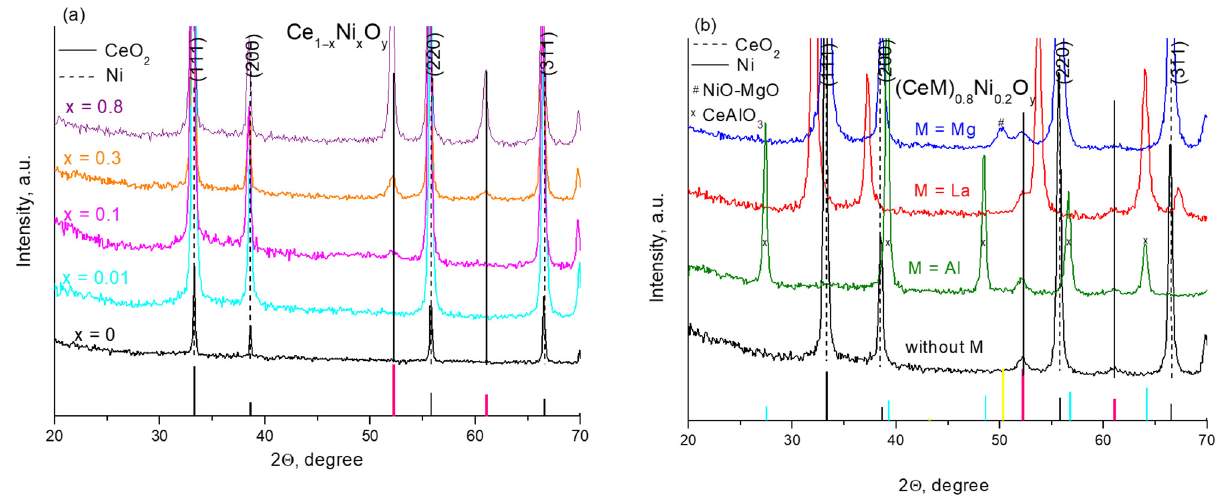
Figure 14. XRD patterns for (CeM) 1 − x Ni x O y (M = Al, La, Mg) samples after activation: effect of Ni molar fraction ( a ) and M type ( b ). ( b )—M/Ce molar ratio is equal to 1. The standard patterns of CeO 2 (ICDD 43–1002, black bars), Ni (ICDD 04–0850, pink bars), MgO (ICDD 45–0946, magenta bars), and CeAlO 3 (ICDD 28–0260 cyan bars) are shown.